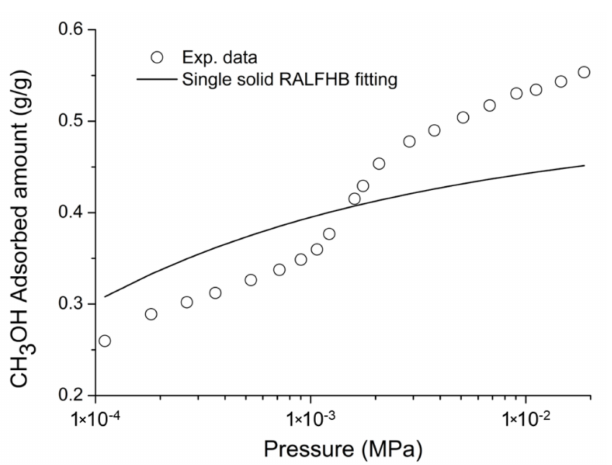
Figure 13. Comparison between experimental adsorption isotherm at 40 ◦ C [58] and optimized model fitting with ‘single solid’ RALFHB model (solid